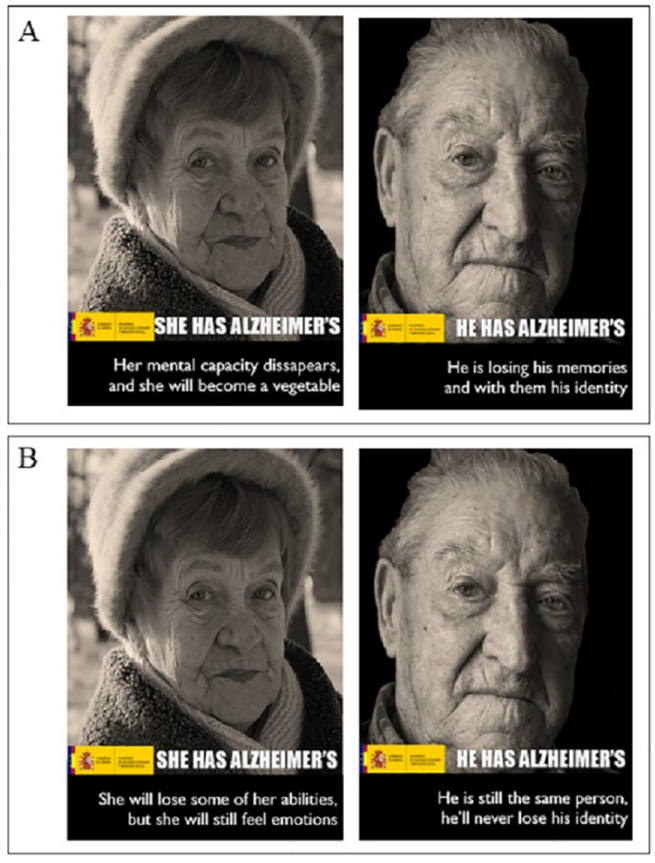
Fig 2. Examples of posters designed for the study. All the images used were downloaded from the Pixabay website and were free of copyright under the Creative Commons CC0 license. Panel A: Examples of posters of dualism framing. Panel B: Examples of posters of unity framing. As can be seen, the posters are similar, the only difference is the type of message used. The text of the posters has been translated from Spanish.